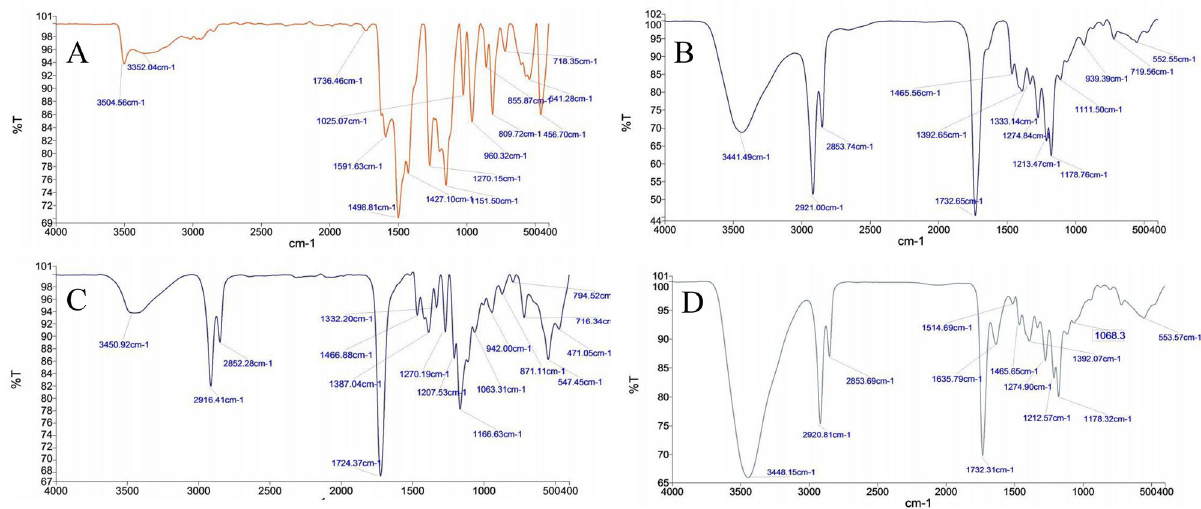
Figure 2. FTIR spectrum of, ( A ) curcumin, ( B ) PGMD polymer, ( C ) 7:3 CUR NPs, ( D ) 6:4 CUR